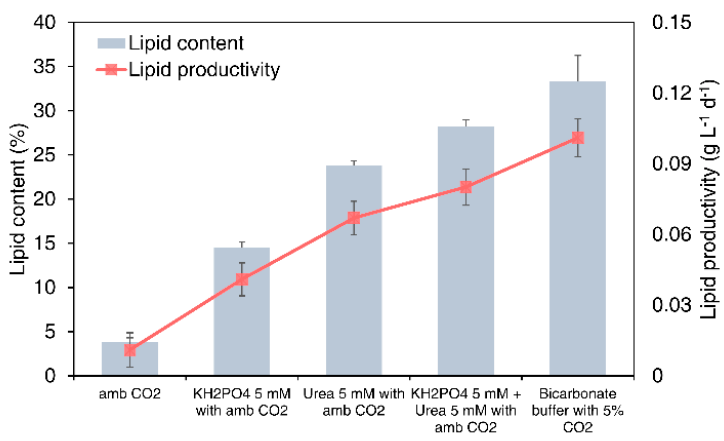
Figure 5. Lipid content and productivity of Chlorella sorokiniana UTEX 2714 after 6 days of nitrogen starvation with different concentrations of CO 2 supplementation (ambient CO 2 and 5% CO 2 ) using urea, KH 2 PO 4 , and bicarbonate buffer system. Results represent the mean ± standard deviation (SD) of three replicates.